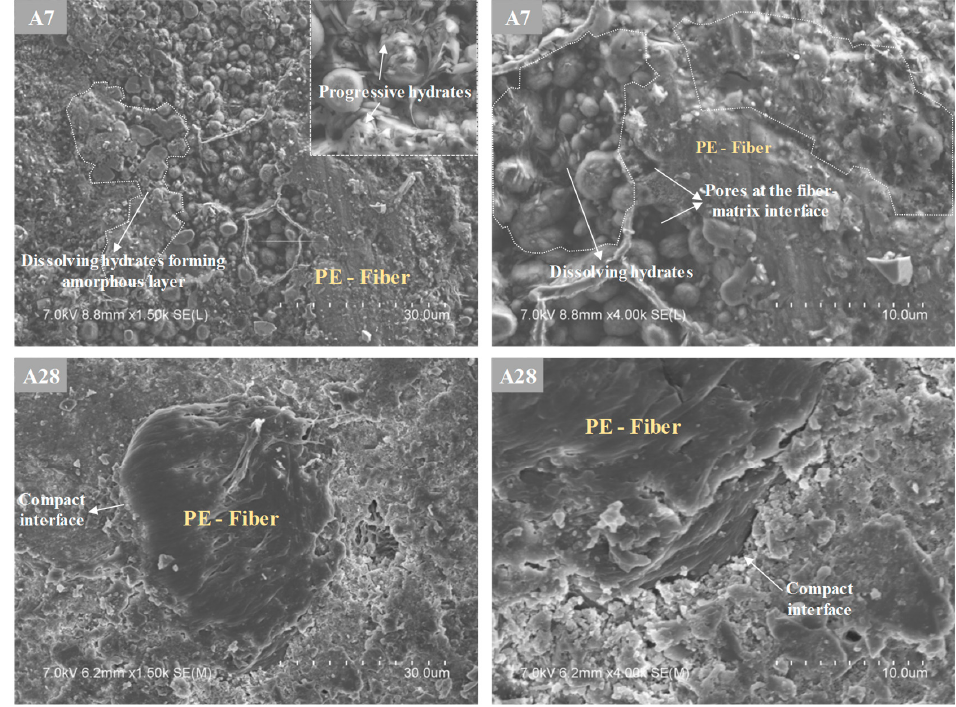
Figure 4. Scanning electron microscopy (SEM) images on the microstructure of specimens A7 and A28.